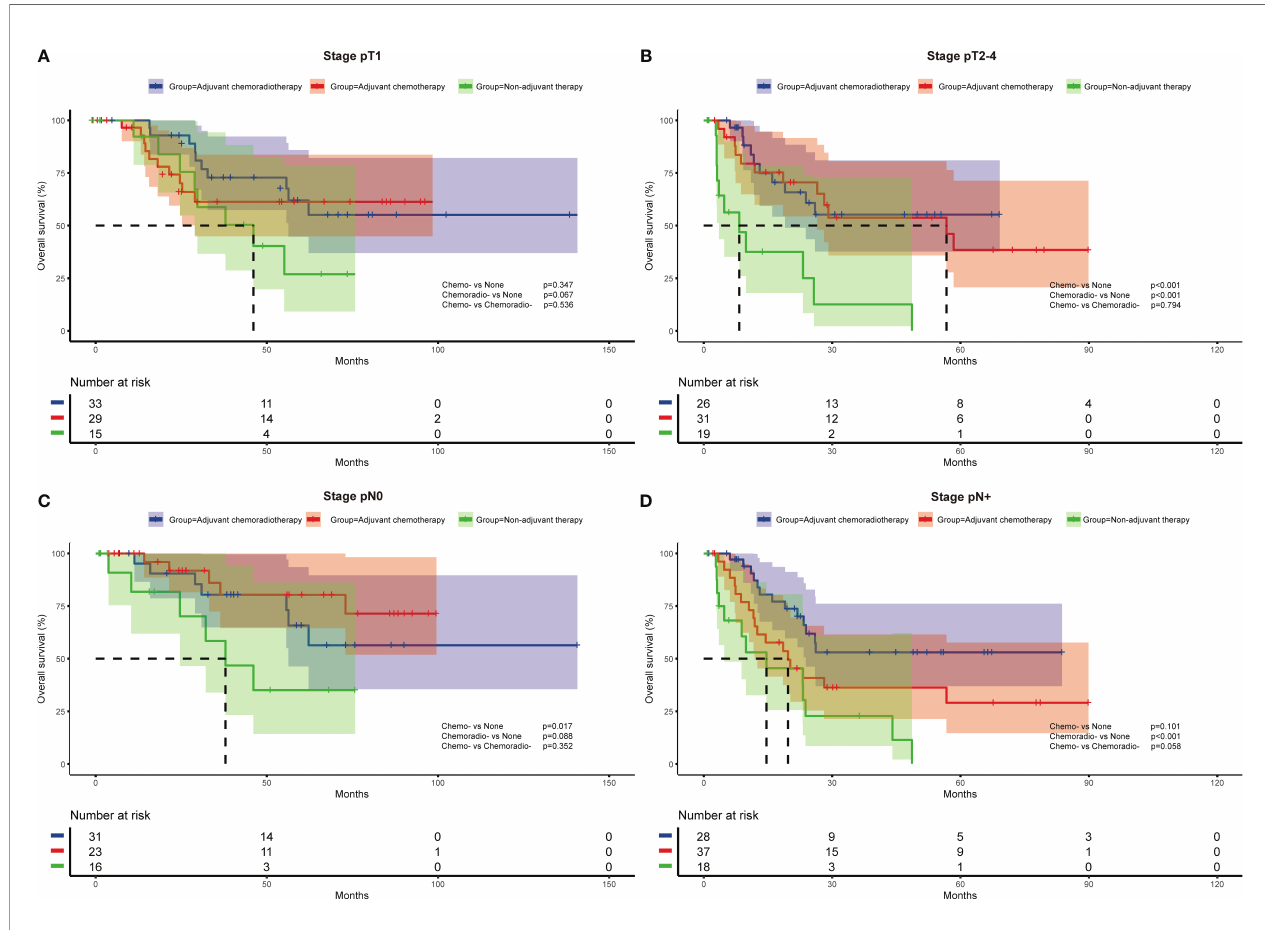
FIGURE 2 | Overall survival of different adjuvant treatment modalities in patients with speci fi c pathologic T stages (A, B) and N stages (C, D) .